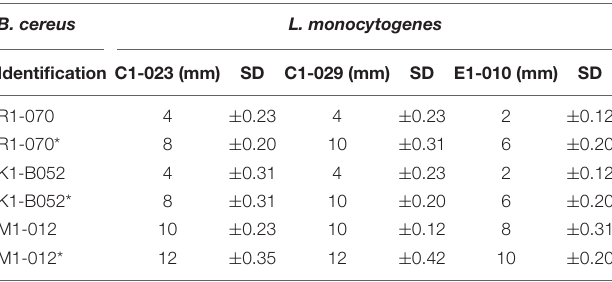
TABLE 1 | Diameters average of inhibition halos of Listeria monocytogenes strains by Bacillus cereus